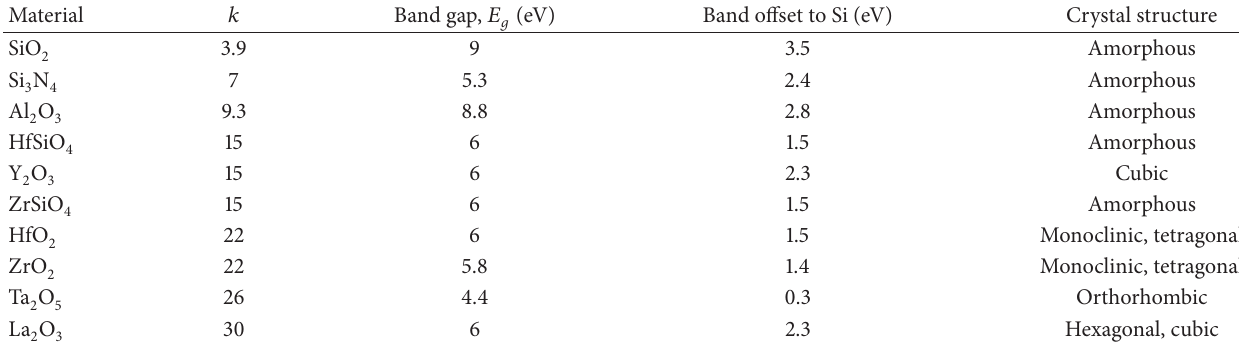
Table 1: Properties of high- 𝑘 dielectric